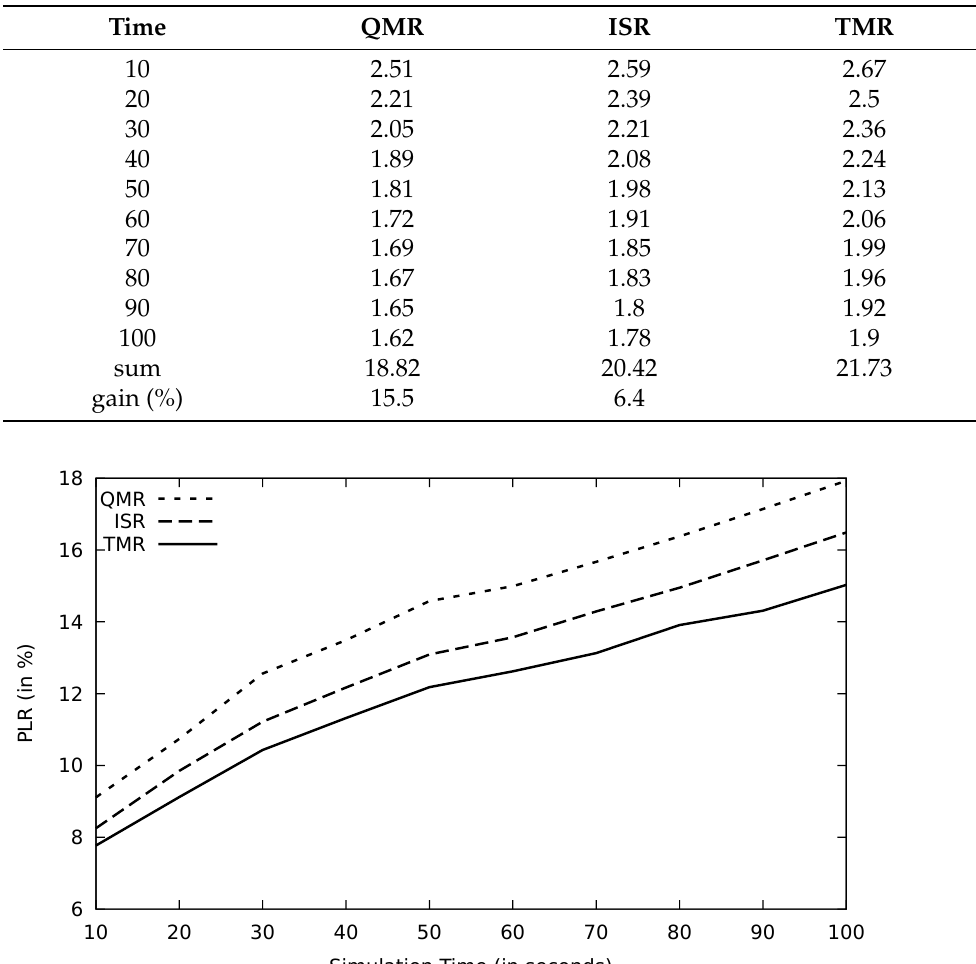
Figure 25. Comparison of EGSR, ISR, and proposed protocol TMR for PLR with simulation